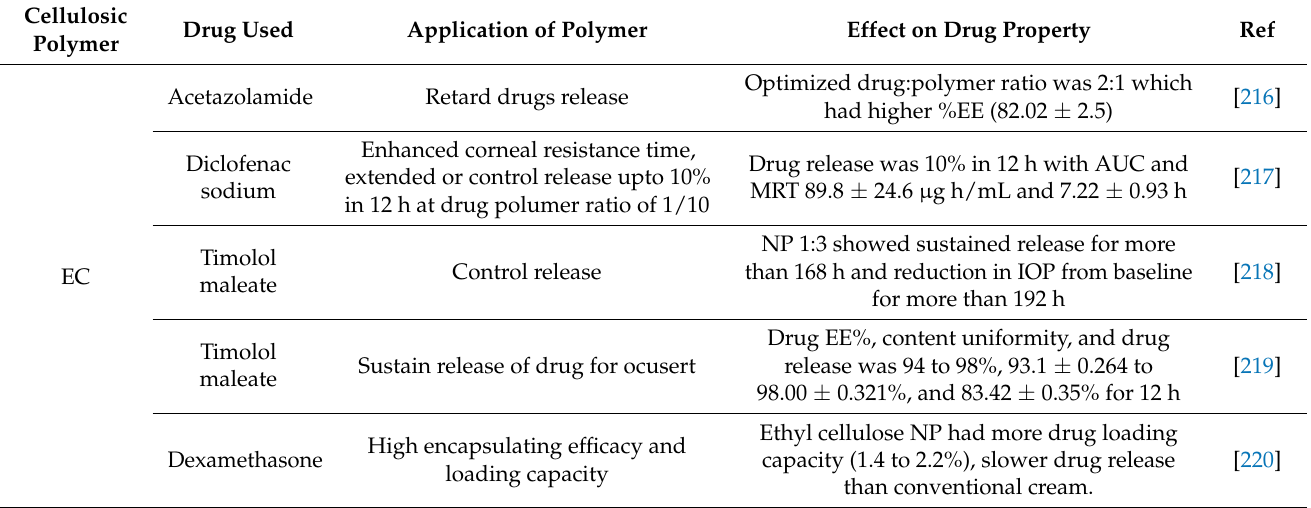
Table 9. Application of EC in ocular drug